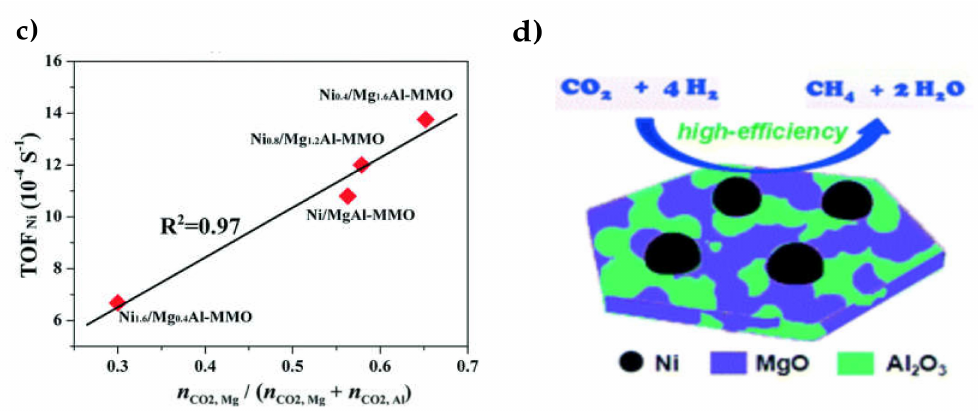
Figure 7. ( a ) CO 2 methanation at steady state as a function of reaction temperature over the as-prepared Ni / MgAl-MMO, Ni / CNT, Ni / Al 2 O 3 and Ni / MgO catalysts (GHSV: 2400 h − 1 ). ( b ) The corresponding selectivity toward CH 4 as a function of reaction temperature. ( c ) Relationship between the TOF Ni values and the concentration of alkaline sites in the Ni x / Mg 2 − x Al-MMO catalyst and ( d ) CO 2 methanation over the hydrotalcite-derived catalysts that consist of Ni nanoparticles finely dispersed over a MgO-Al 2 O 3 mixed oxide support (Ni / MgAl-MMO). Reproduced with permission from ref. [90]. Copyright 2016 Royal Society of